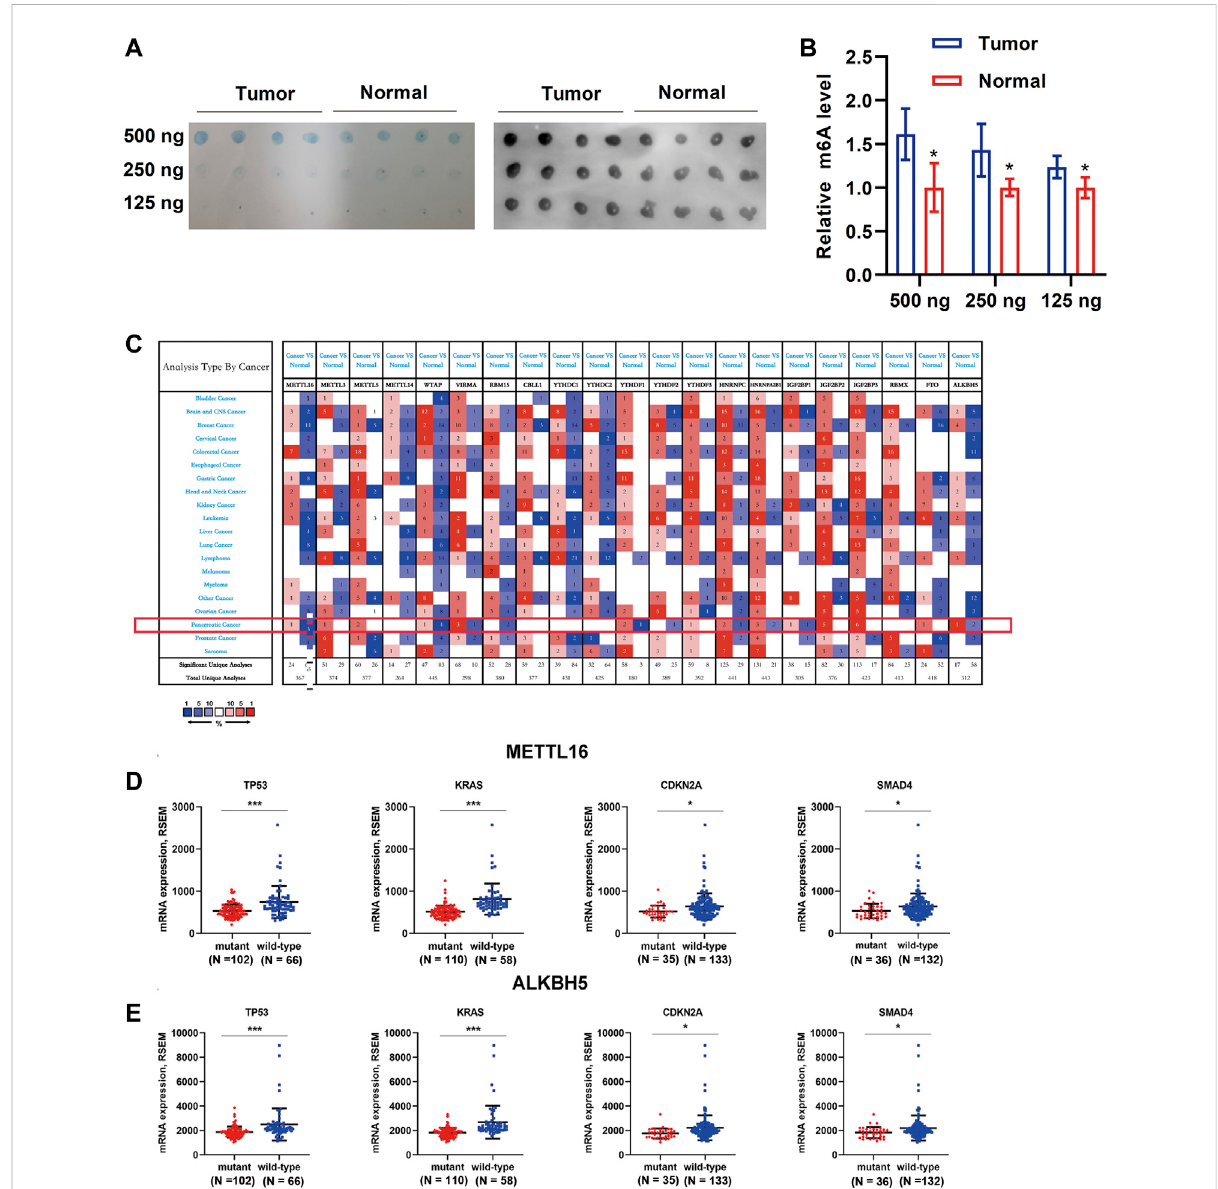
FIGURE 1 Global m 6 A levels in PDA tissue samples and transcription levels of m 6 A regulators in different cancer types. (A) Global m 6 A level of RNA extracted from PDA tissues ( N = 4) and adjacent normal tissues ( N = 4) was detected via m 6 A dot blot assays. RNAs were serially diluted and loaded equally with the amount of 500, 250, and 125 ng. Methylene blue staining (left) served as a loading control. (B) Histogram of m 6 A dot blot analysis indicated that an enhanced m 6 A level was observed in PDA tissues. (C) Analysis of transcription levels of 21 m 6 A regulators in different cancer types vs. matched normal tissues. A darker color indicates a higher number. The numbers in the colored cells represent the numbers of datasets meeting the criteria ( p -value, 0.05; fold change, 1.5). The red pattern indicates upregulation, and the blue one indicates downregulation of genes in different analyses. Only METTL16 (D) and ALKBH5 (E) were expressed aberrantly when one of the driver genes that characterize PDA was mutated. Downregulation of METTL16 and ALKBH5 was observed in mutant tissues compared with wild-type tissues. * p < 0.05, *** p <